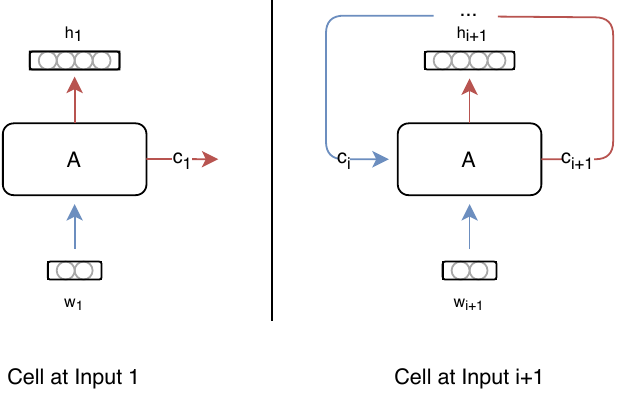
Figure 1. State of the recurring cell during